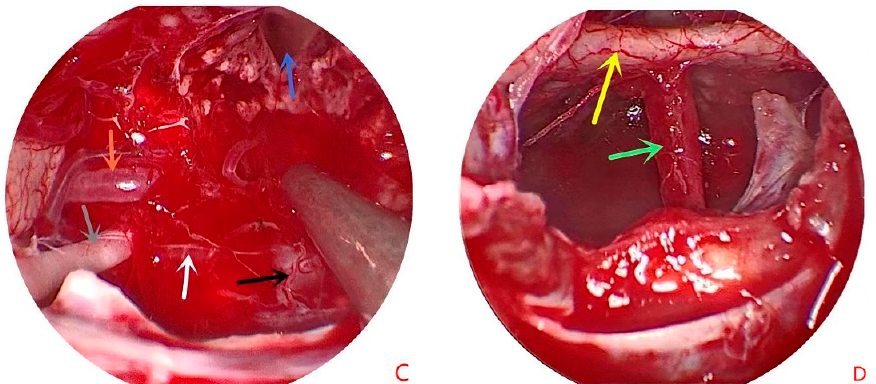
Figure 2. Endoscopic images during surgery. ( A , B ) Opening the dura mater at the bottom of the sella, a gray–white tumor (purple arrows) located behind the pituitary stalk (green arrows), and below the optic chiasm (yellow arrows). ( C , D ) Following the removal of the tumor, the third ventricle (blue arrow), oculomotor nerve (gray arrow), posterior cerebral artery (orange arrow), and basilar artery (black arrow) can be observed.